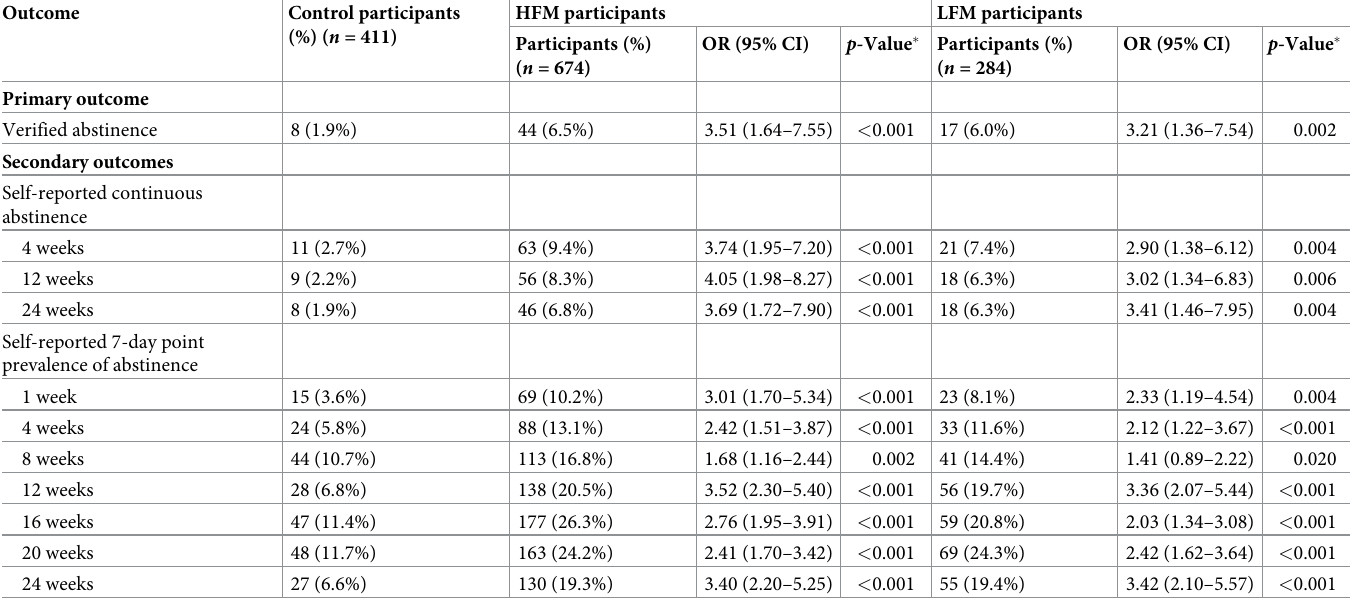
Table 2. Verified continuous smoking abstinence and 7-day point prevalence (intention-to-treat) by group.